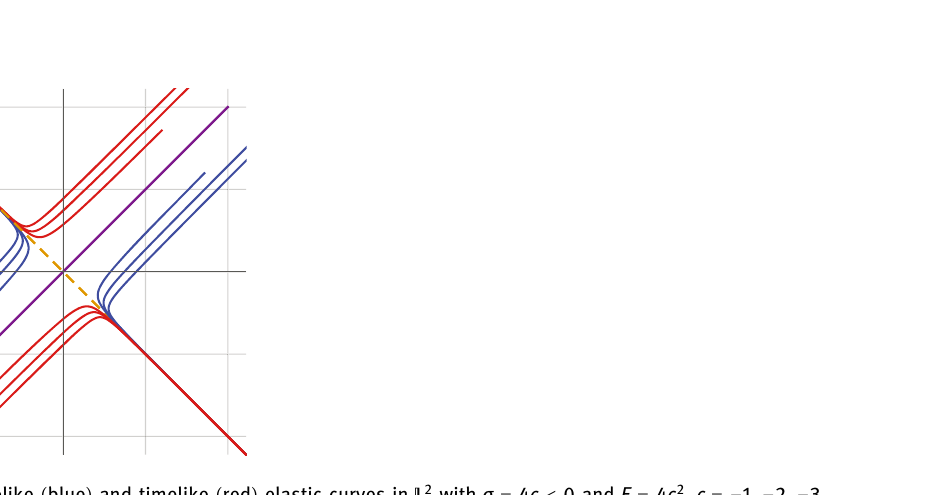
Figure 16: Spacelike ( blue ) and timelike ( red ) elastic curves in (cid:2) 2 with = < σ c 4 0 and = E c 4 2 , = c −1, −2, −3